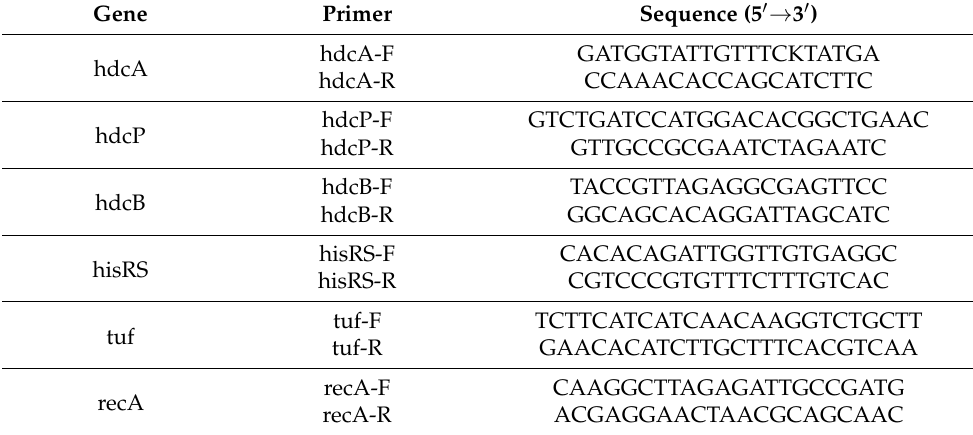
Table 1. Primers used in this